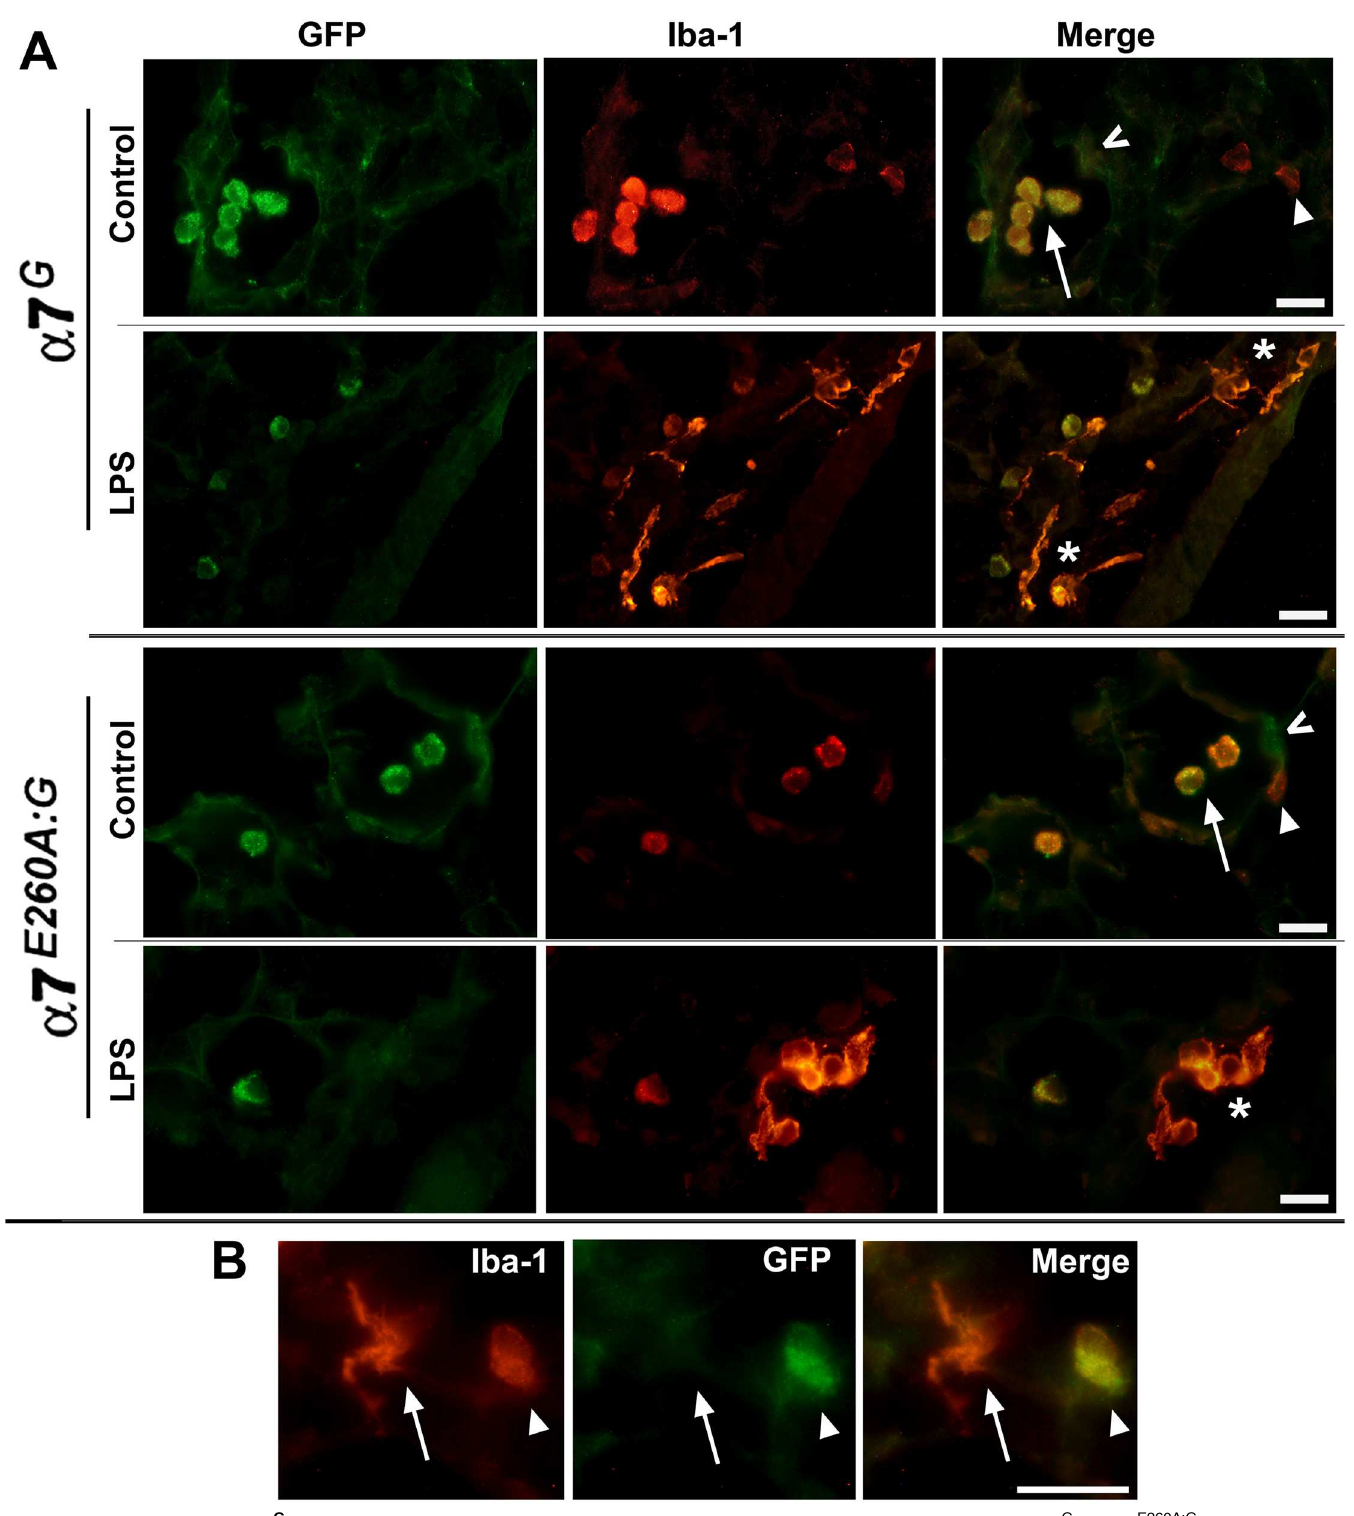
Fig 1. Immunostaining for α 7 G tGFP reporter expressionin lung immune cells co-expressing Iba-1. A) In both the α 7 G and α 7 E260A:G mouse tGFP is produced as a bicistronic reporter of α 7 transcript expression. Immunohistochemistry of the lungs from these animalsrevealsstrong GFP expressionby alveolarmacrophages (AM; arrow) that are co-labeledby Iba-1 (red) in the control (saline) or i.n. LPS treated lungs of both α 7-genotypes. Also present in